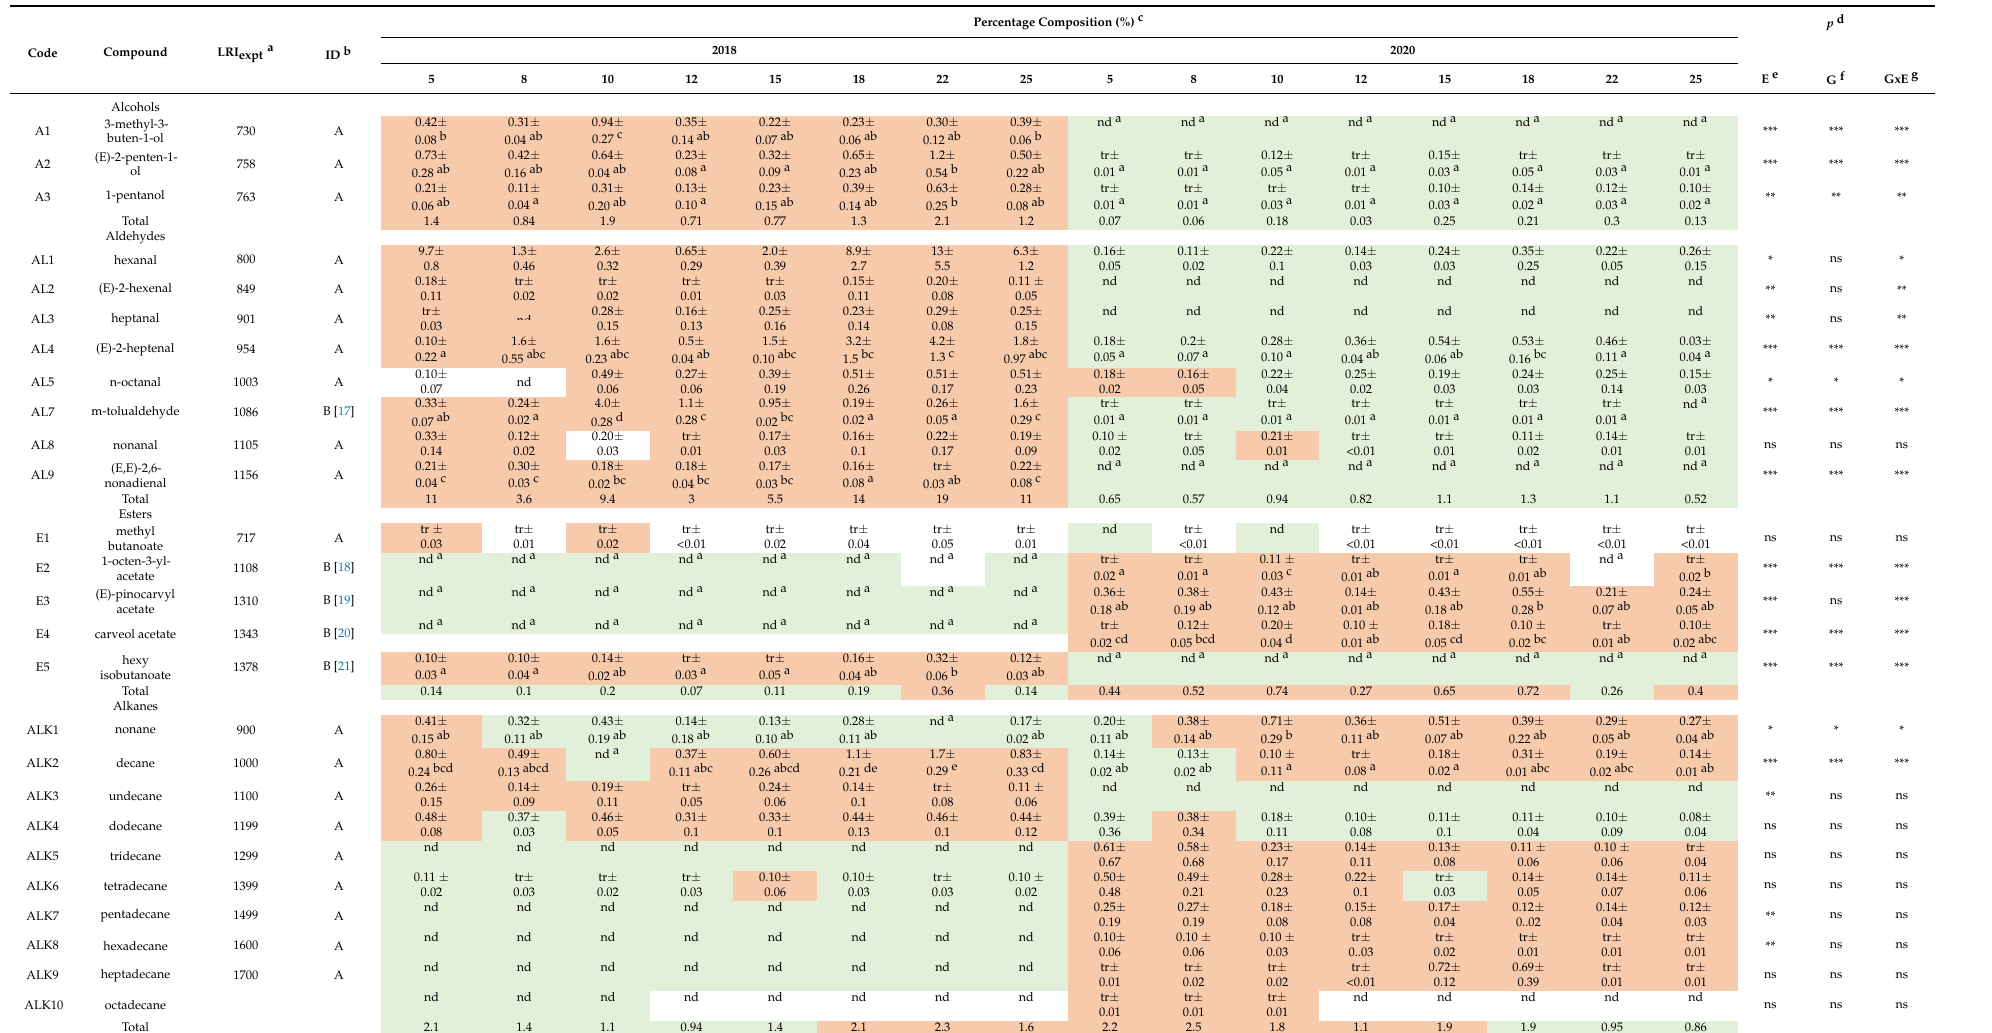
Table 1. Percentage composition of volatile compounds identified in the headspace of eight celery genotypes using SPME GC/MS and harvested in 2018 and